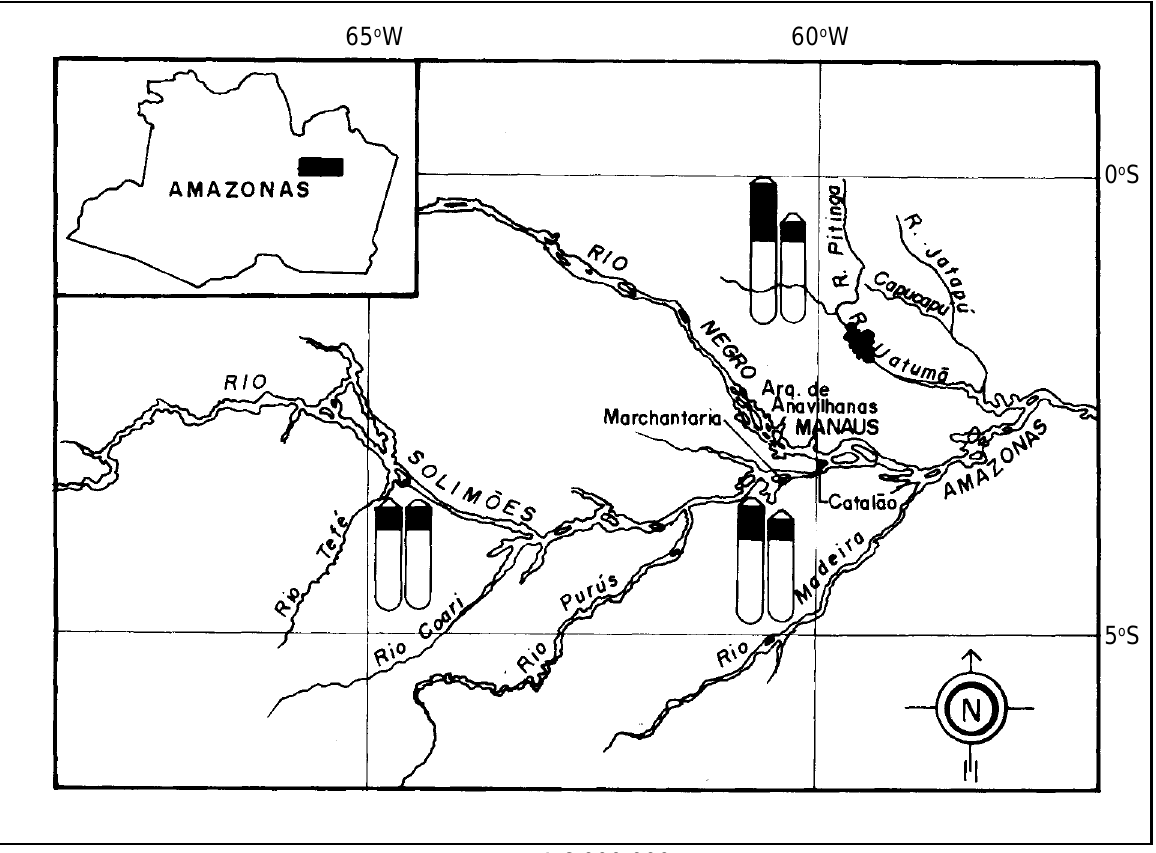
Figure 1 - Map of central Amazon showing capture localities and idiograms of NOR phenotypes of Plagioscion squamosissimus